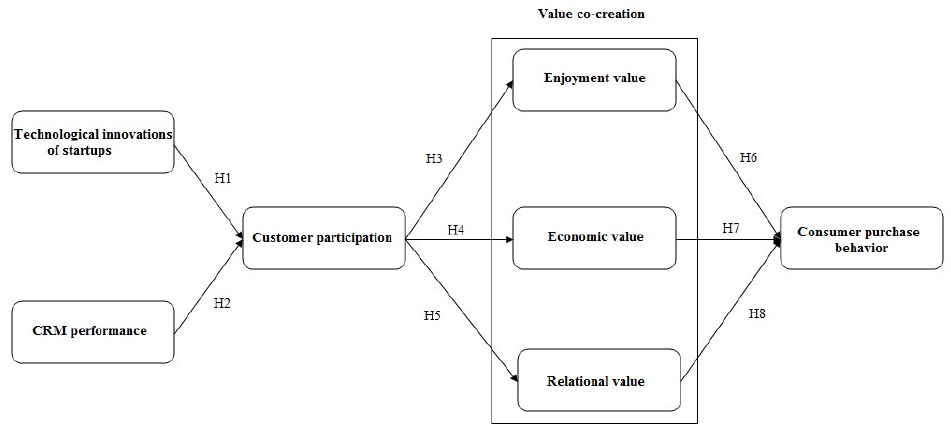
Figure 1. Theoretical model.